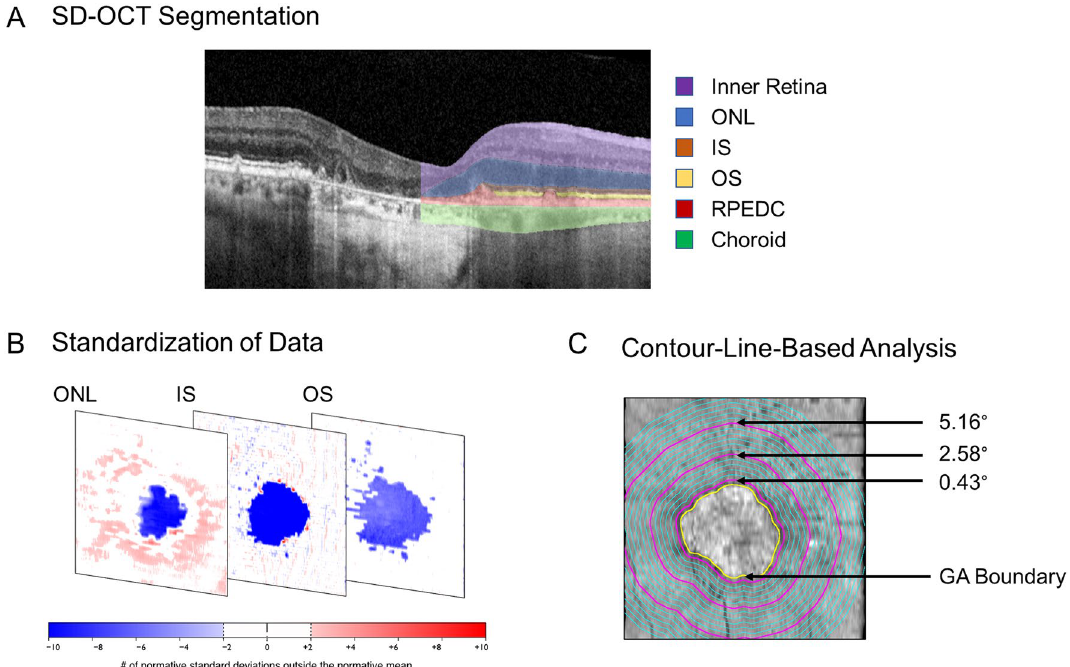
Figure 1. Image segmentation approach. As shown in the first panel, all spectral-domain optical coherence tomography (SD-OCT) data were segmented using a convolutional neural network (CNN, Deeplabv3 model with a ResNet-50 backbone). Subsequently (second panel), these data were standardized (z-scores) to account for normal thickness variation due to age and retinal topography. Last (third panel), the retinal layers’ thicknesses were extracted along evenly spaced contour-lines surrounding the retinal pigment epithelium (RPE) atrophy area. The yellow line denotes the boundary of RPE atrophy. The three purple lines represent the 0.43°, 2.58°, and 5.16° contour-lines. spectral-domain optical coherence tomography (SD-OCT), convolutional neural network (CNN), retinal pigment epithelium (RPE), outer nuclear layer (ONL), photoreceptor inner segments (IS), photoreceptor outer segments (OS), retinal pigment epithelium-drusen complex